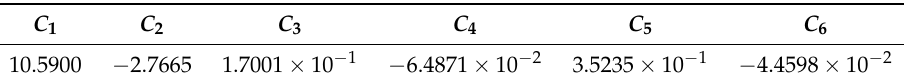
Table 5. Coefficients of the Model for Rain Absorption Below 10mmh − 1